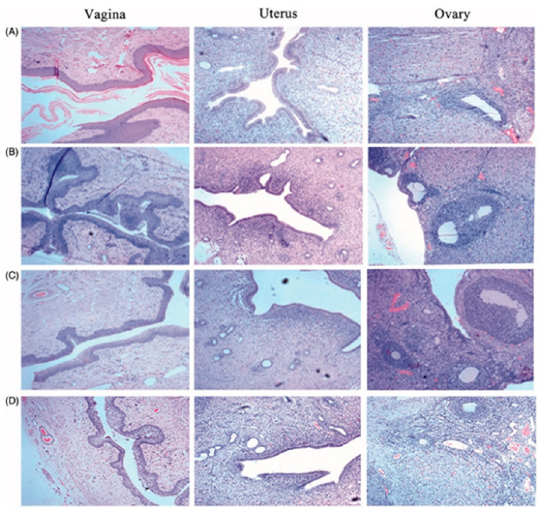
Figure 5. Foam properties of the optimized expansible thermal gelling foam aerosol gel (ETGFA) formulation. ( C 1 ) the pale white colour foam generated is dense and in a relatively small volume upon spurted out from the sealed container; ( C 2 ) the foam expands to a larger size with puff texture; ( C 3 ) the foam reaches the maximum expansion state within 10 min; and ( C 4 ) the foam retained the maximum expansion up to 60 min. Adapted from “Expansible Thermal Gelling Foam Aerosol for Vaginal Drug Delivery” by Mei et al. [111].